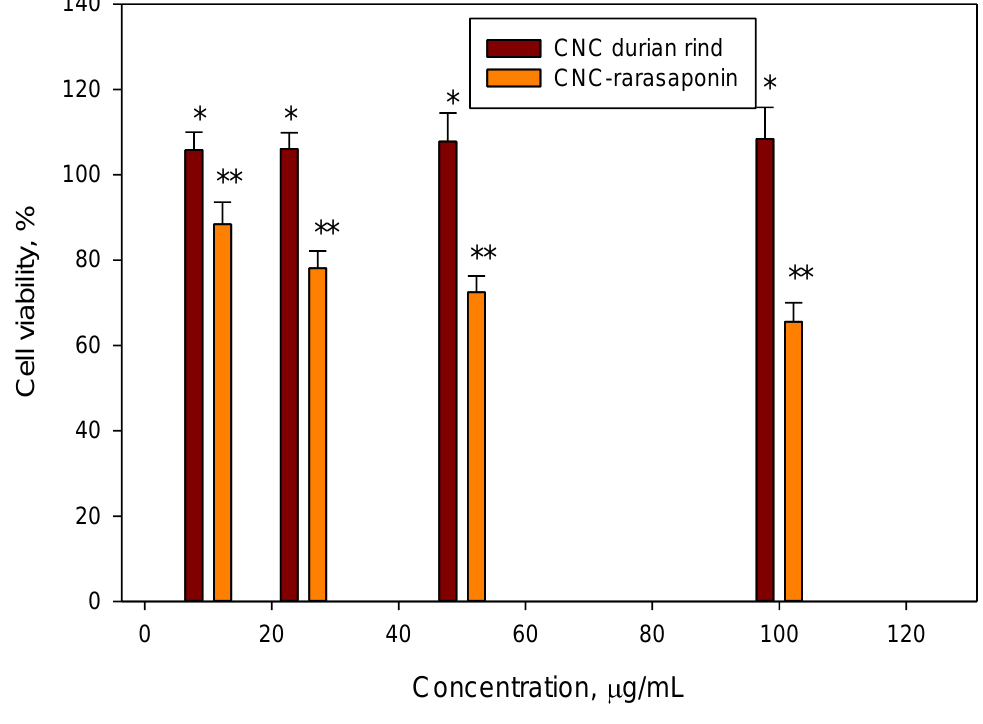
Figure 8. Cell viability of CNCs and CNCs-rarasaponin. Data represent the mean ± SD ( n = 3), * indicates p < 0.05, and ** indicates p < 0.01 (statistically significant difference).